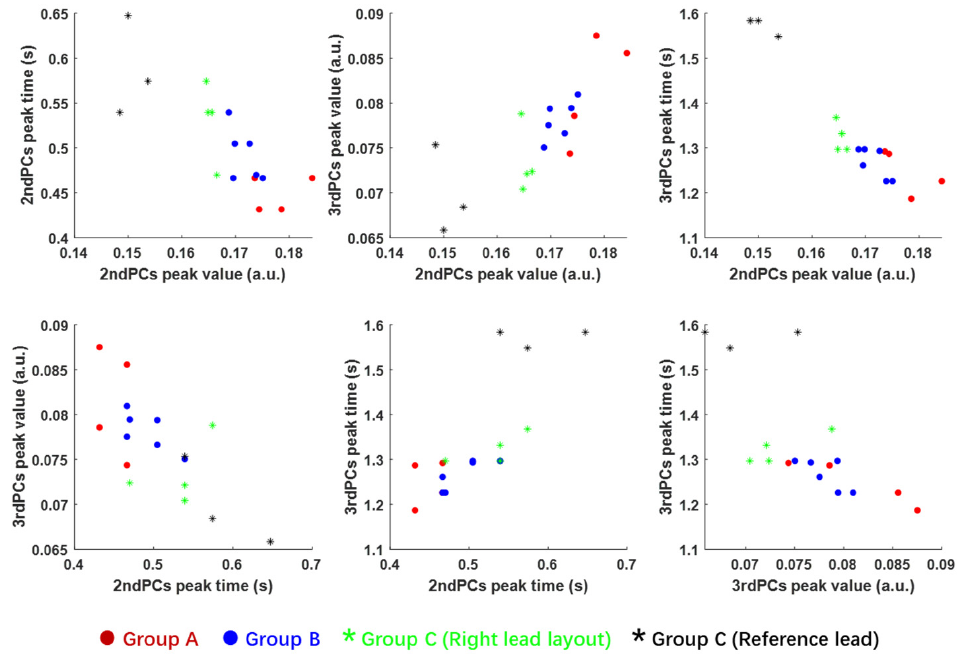
Figure 15. Scatter plots of different feature combination for Group A, B and C.